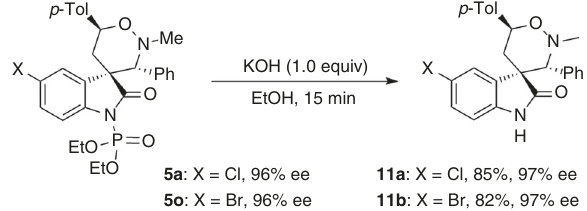
Fig. 5 Deprotection of product 5a and 5o . Reaction conditions: 5 (0.1